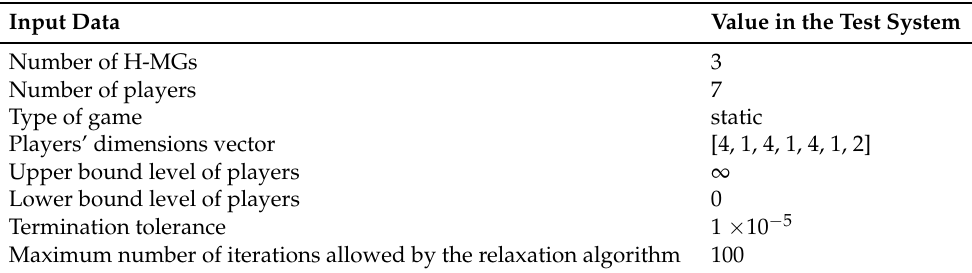
Table A1. The input data of the proposed game